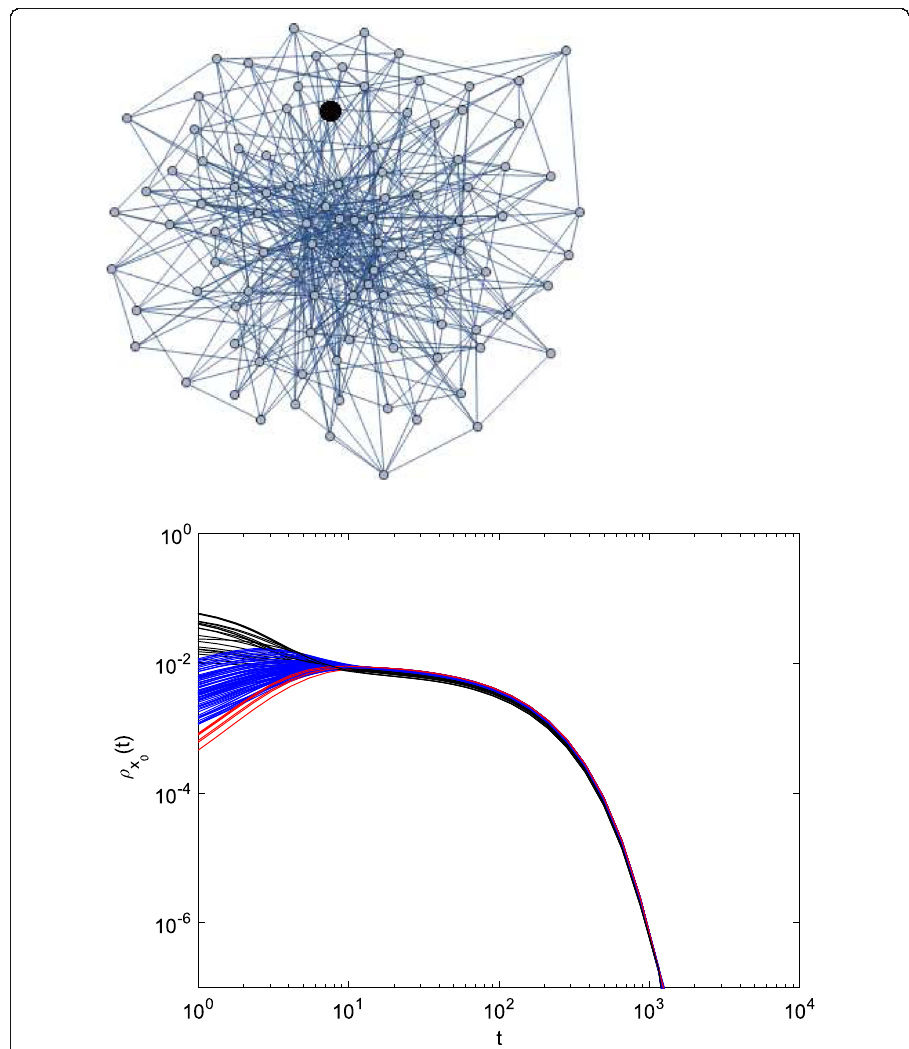
Fig. 6 (Top) Example of a SF network with the fixed absorbing x a marked by black circle. (Bottom) FPT densities on SF network G(N; m; m 0 ) N = 100, m = 5, m 0 = 6 for different starting points x 0 and a fixed absorbing node x a : ∣ x 0 − x a ∣ = 1 (black), ∣ x 0 − x a ∣ = 2 (blue), ∣ x 0 − x a ∣ = 3 (red). The travel